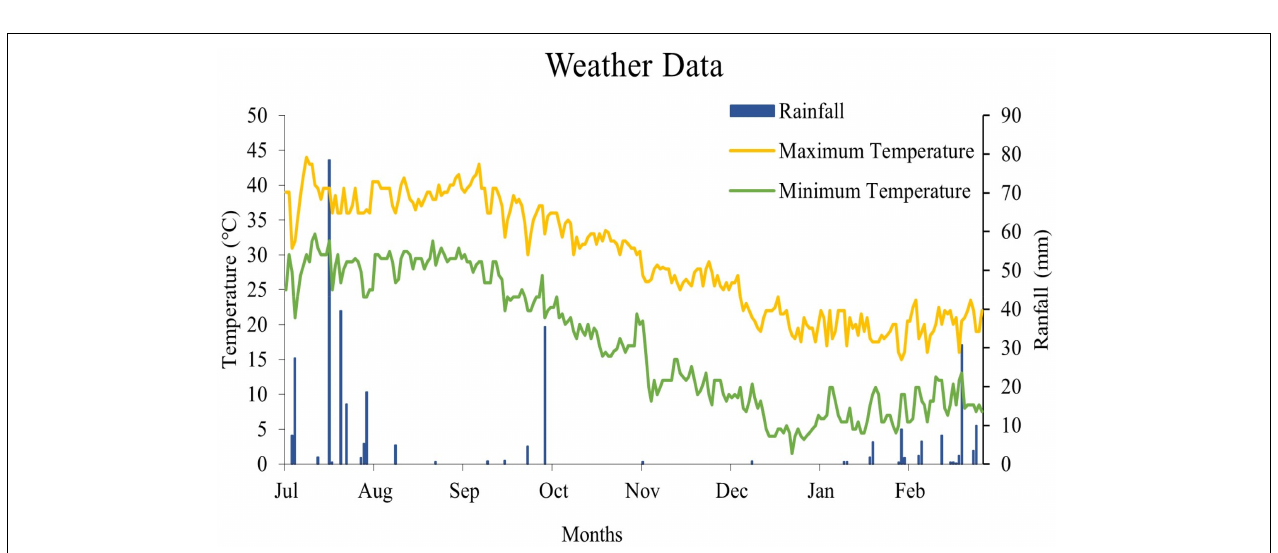
FIGURE 1 | Temperature and rainfall data of the growing season at field experimental site.